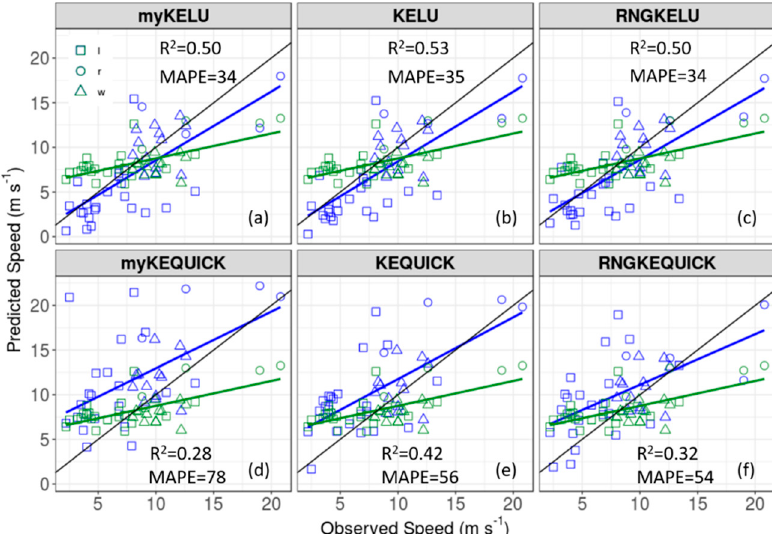
Table 7. Model root mean square error (RMSE), mean bias error (MBE), and mean absolute percent Figure 16. Observed versus predicted wind speeds at Big Southern Butte using ( a ) myKELU; ( b ) KELU; error (MAPE) for wind speeds at windward (w), ridgetop (r), and leeward (l) sensor locations at Big Figure 16. Observed versus predicted wind speeds at Big Southern Butte using ( a ) myKELU; ( b ) ( c ) RNGKELU; ( d ) myKEQUICK; ( e ) KEQUICK; ( f ) RNGKEQUICK. Blue symbols are for the CFD Southern Butte. Positive MBE indicates model over ‐ prediction. Bold font indicates the lowest error at KELU; ( c ) RNGKELU; ( d ) myKEQUICK; ( e ) KEQUICK; ( f ) RNGKEQUICK. Blue symbols are for the solver and green symbols are for the COM solver. The blue and green lines represent the ordinary each location. CFD solver and green symbols are for the COM solver. The blue and green lines represent the least squares line of best fit for the CFD and COM solver, respectively. The black line is the 1:1 line. ordinary least squares line of best fit for the CFD and COM solver, respectively. The black line is the The mean absolute percent error (MAPE) and coe ffi cient of determination (R 2 ) for the COM solver are 1:1 line. The mean absolute percent error (MAPE) and coefficient of determination (R 2 ) for the COM 46 and 0.39, solver are 46 and 0.39, respectively.